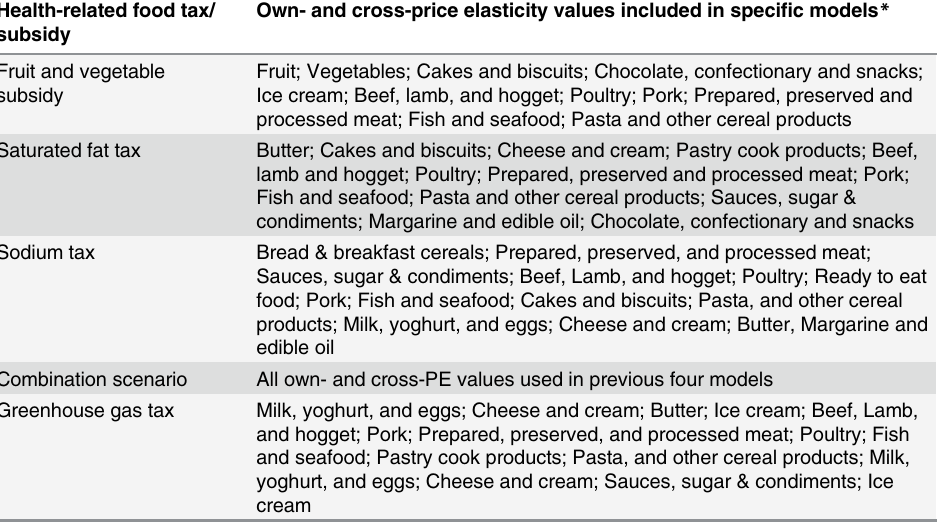
Table 2. Food group price elasticity values included in taxation and subsidy models. Health-related food tax/